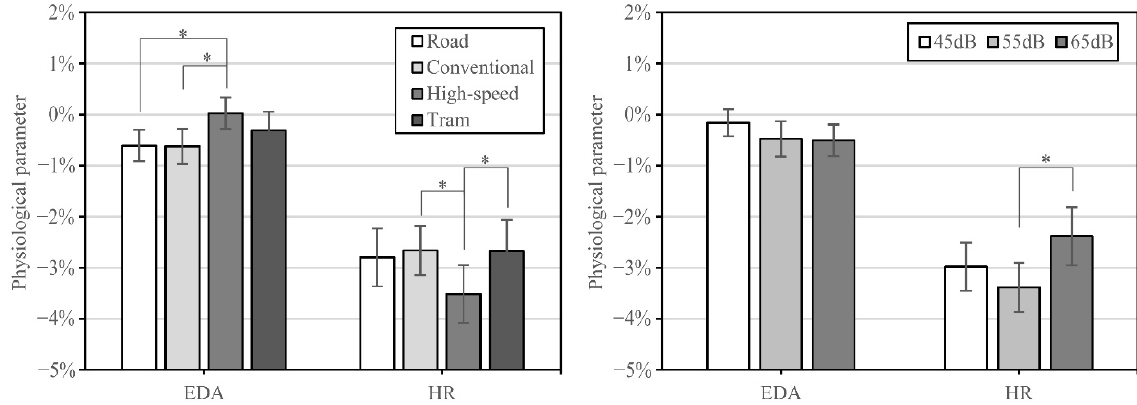
Figure 8. Main effect of noise type and noise level on physiological responses. * represents significant differences in LSD pairwise comparison at the 0.05 level.